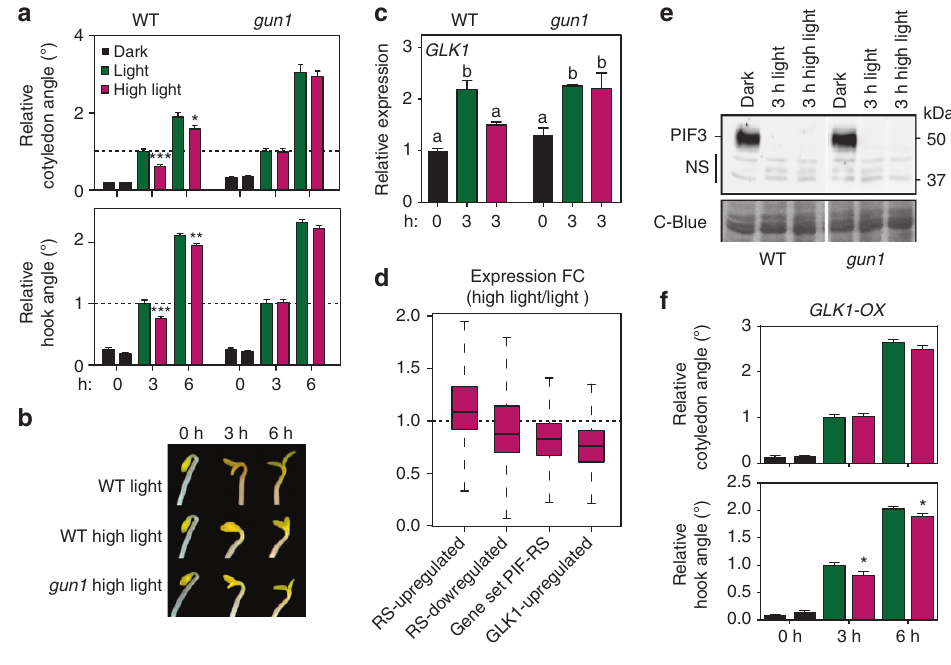
Figure 5 | High-intensity light induces GUN1-facilitated RS and inhibits PIF-mediated early light-induced deetiolation. ( a ) Hook unfolding and cotyledon separation were significantly slower in dark-grown WT seedlings after 3 and 6h of high light treatment (purple) compared with light (green), while gun1 mutant seedlings were insensitive to high light and deetiolated at the same rate in both light and high light. Values for each genotype are expressed relative to the corresponding value in light at 3h set at one ( n Z 65). ( b ) Visual phenotype of representative seedlings in a . ( c ) Light-induction of GLK1 in dark-grown WTseedlings is significantly reduced in high light (purple) compared with light (green), while gun1 mutant seedlings are insensitive to high light and reached similar levels of GLK1 induction in light and high light. Data are the means ± s.e.m. of biological triplicates ( n ¼ 3). Different letters denote the statistically significant differences among means (Tukey-b test). ( d ) Fold-change expression between WTseedlings grown in high light and light for the following gene sets: RS-upregulated 27 , RS-downregulated 27 , Gene-Set PIF-RS and GLK1-upregulated 17 . Data were obtained from ref. 35. ( e ) PIF3 protein levels in WT and gun1 dark-grown seedlings were below level of detection after 3h in light or in high light. ( f ) GLK1-OX seedlings were largely insensitive to high light and deetiolated similarly in both light (green) and high light (purple; n Z 45). In a and f , error bars represent s.e.m. and the statistically significant differences between light treatments at each time point by Student’s t -test are shown (* P o 0.05; ** P o 0.01 and *** P o 0.001). The experiments were repeated two times with similar results. C-blue, coomassie blue; NS, non-specific bands. NATURE COMMUNICATIONS|7:11431|DOI: